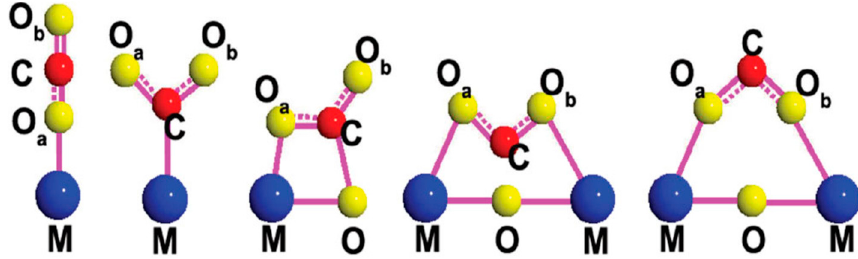
Figure 2. Five possible CO 2 adsorption configuration models on metal oxide semiconductors. M: Metal C: Carbon O: Oxygen. Reproduced from work in [44] . Copyright 2014 Wiley-VCH.